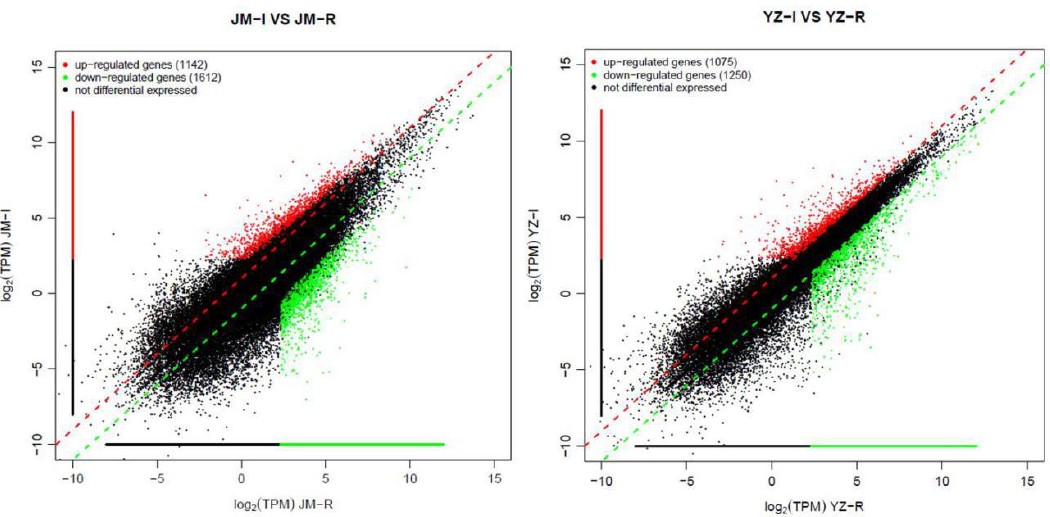
Figure 2. The differentially expressed genes between irrigation and rain-fed condition identified in drought-tolerant genotype Jimai No. 47 and drought-sensitive genotype Yanzhan No. 4110. JM = the Jimai No. 47 (drought-tolerant) and YZ = Yanzhan No. 4110 (drought-sensitive); I = irrigation; R = rain-fed (drought) .